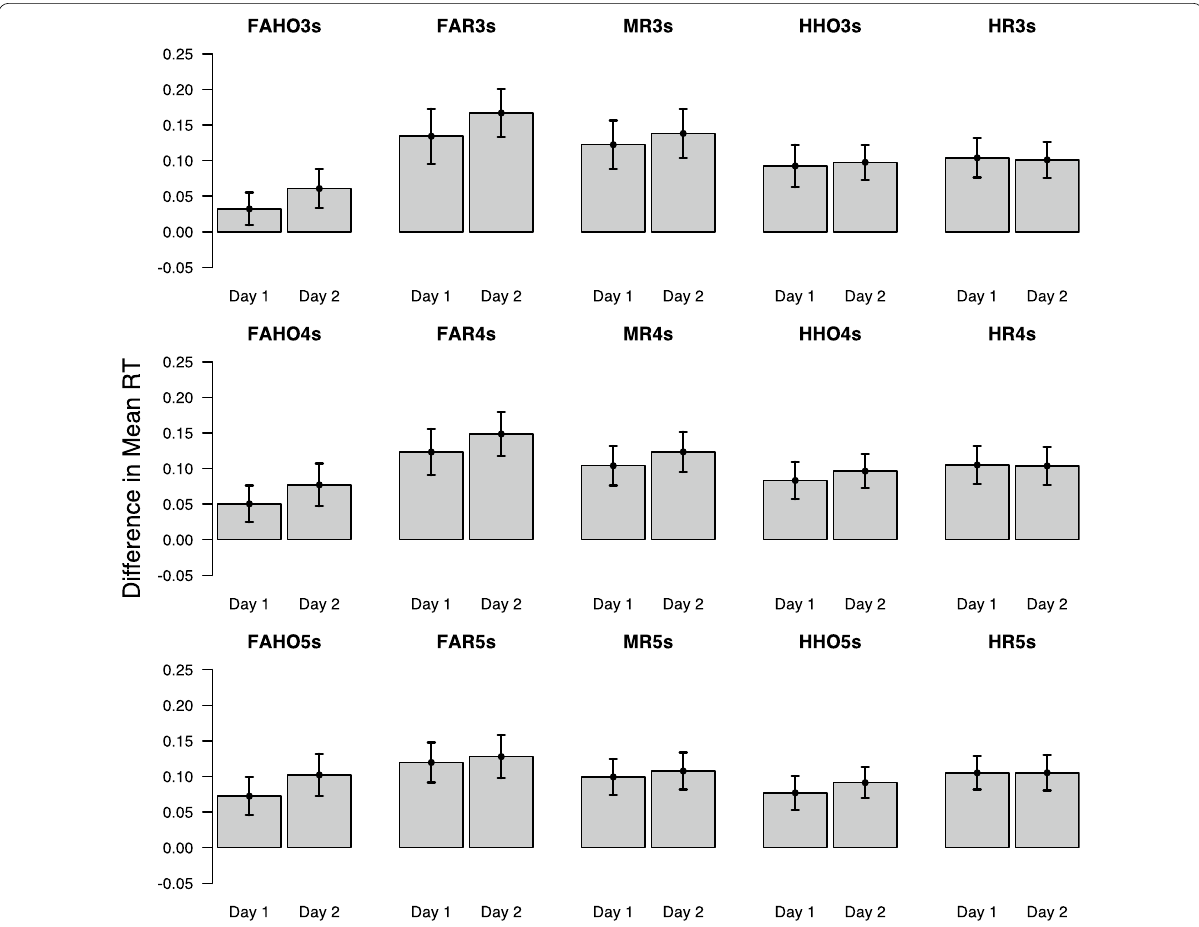
Fig. 5 Effect of different UAV-task events on response time (RT) for different time windows prior to the DRT prompt. Top row: 3-s time window; middle row: 4-s time window; bottom row: 5-s time window. Error bars show mean difference